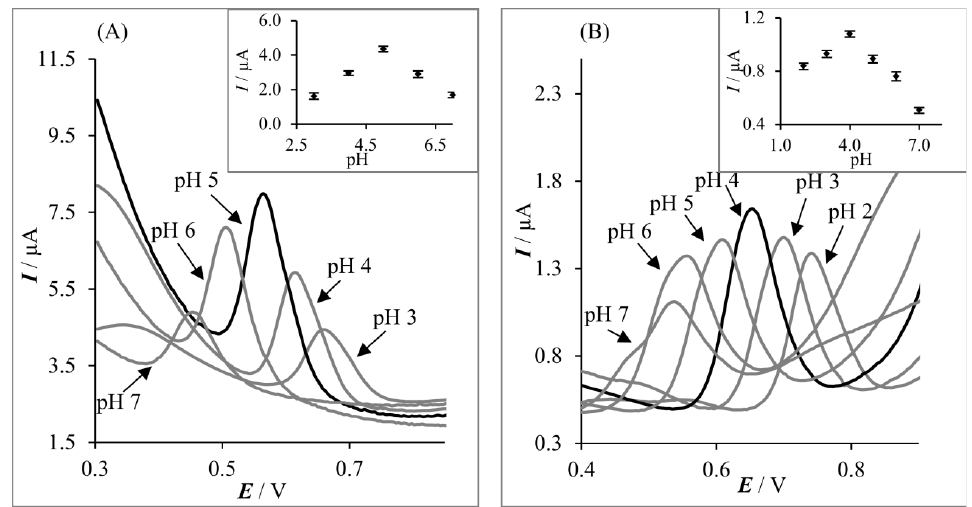
Figure 5. SW voltammograms of 5.0 μmol L −1 acetaminophen recorded in BR buffers for ( A )